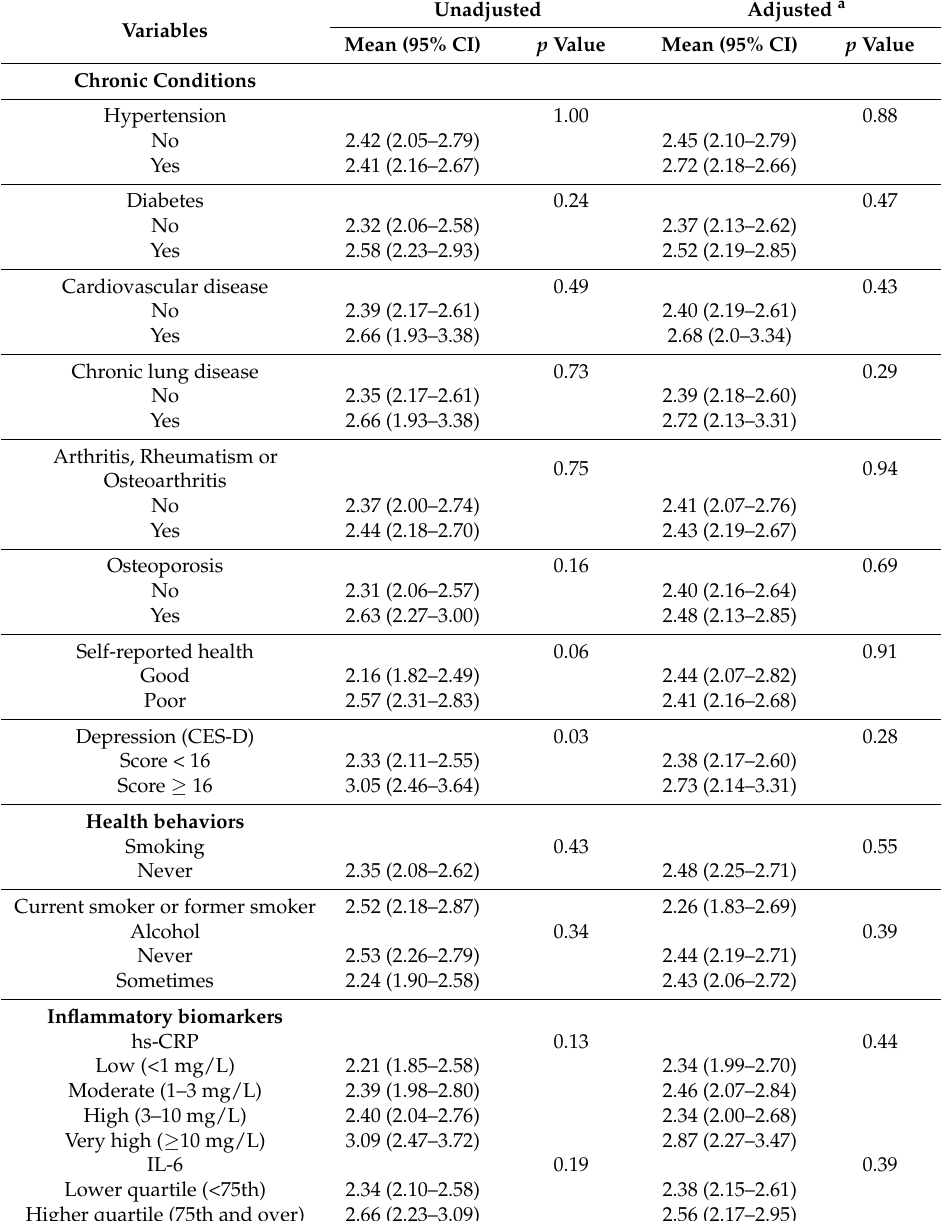
Table 2. Mean (unadjusted and adjusted) of ln T/S ratio for chronic conditions, health behaviors and inflammatory markers ( n =